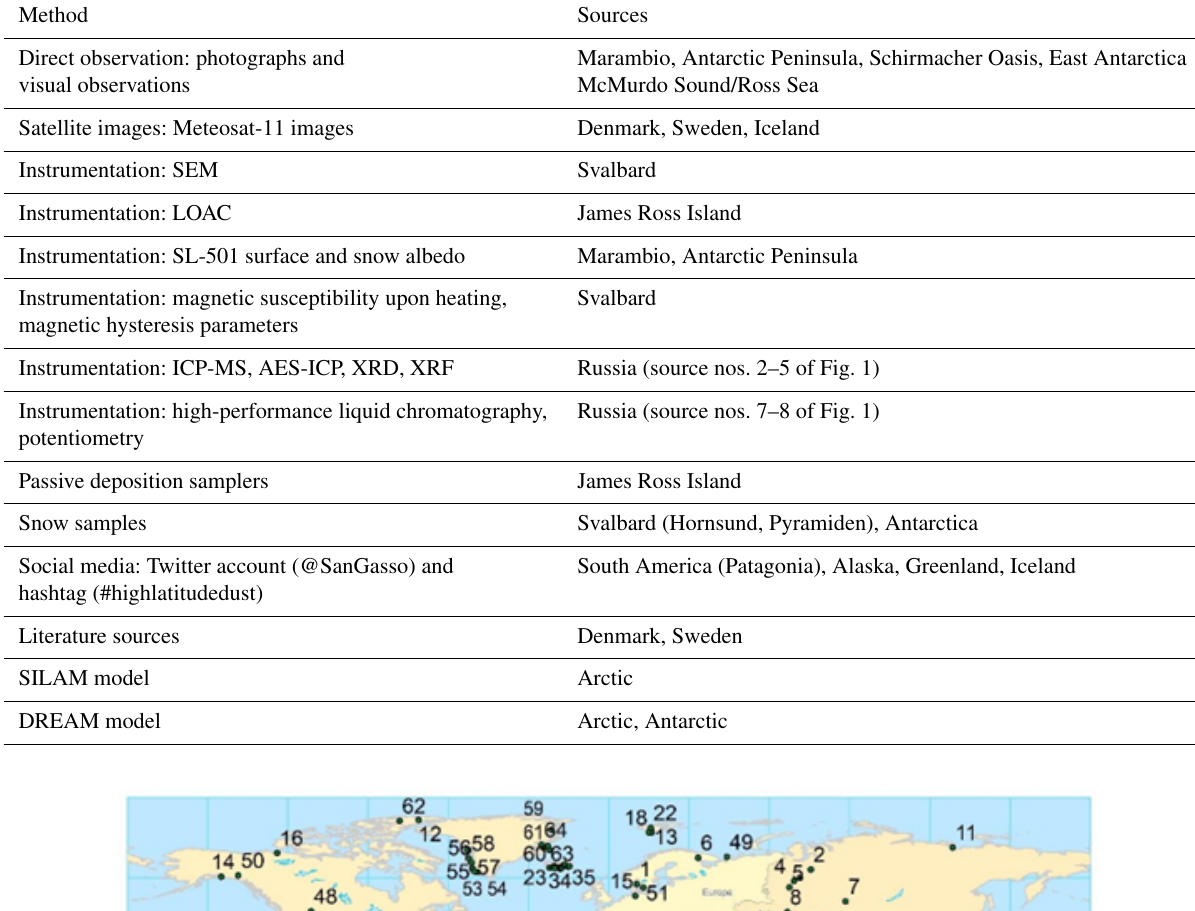
Table 1. Methods used to identify and study the dust sources.